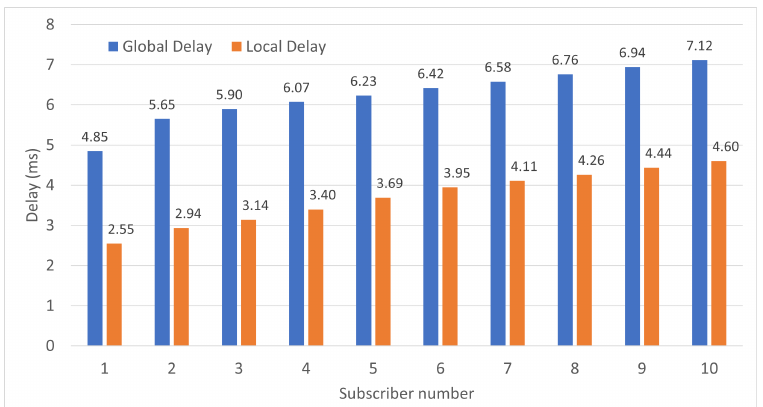
Figure 9. Comparison of delay for 10 local subscribers with 10 global subscribers for a single buffer of size 100 bytes.